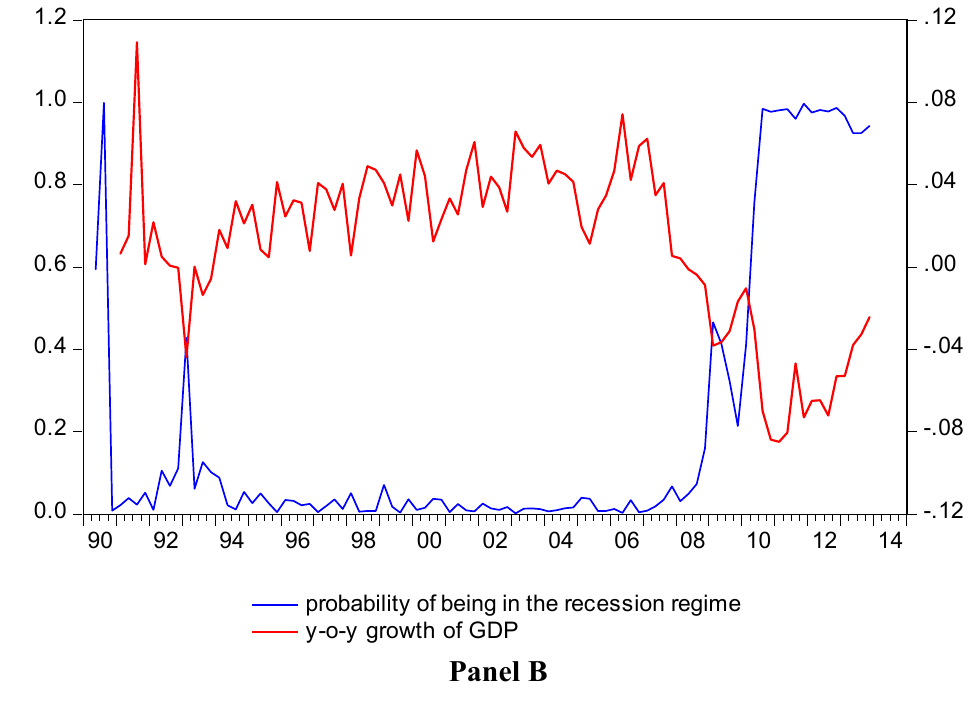
Figure 2. Panel A : Filtered probabilities of State 2 (being in the recession regime) in the left axis and the de-seasonalized GDP in the right axis. The sample period runs from 1990q1 to 2013q4. Panel B : Filtered probabilities of being in the recession regime (left axis) and the y-o-y growth of GDP (right axis). Table 2. The estimated coefficients of the regime switching